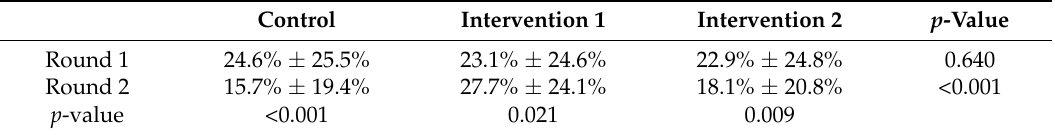
Table 3. DDI-related performance by intervention arm and round: DDI-related treatment performance.